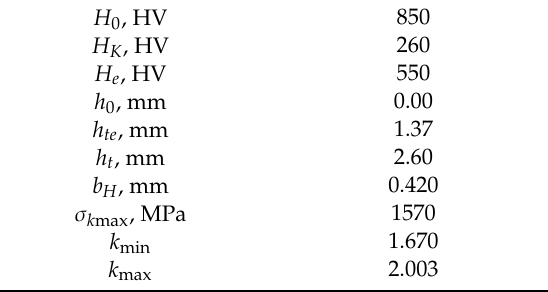
Table 4. Initial data for DCS accessing of sample